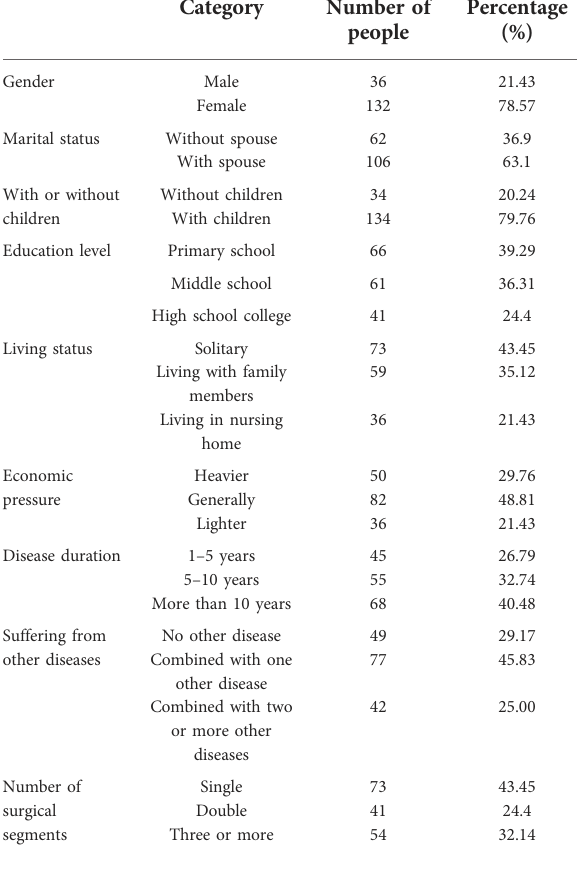
TABLE 1 General demographic data.